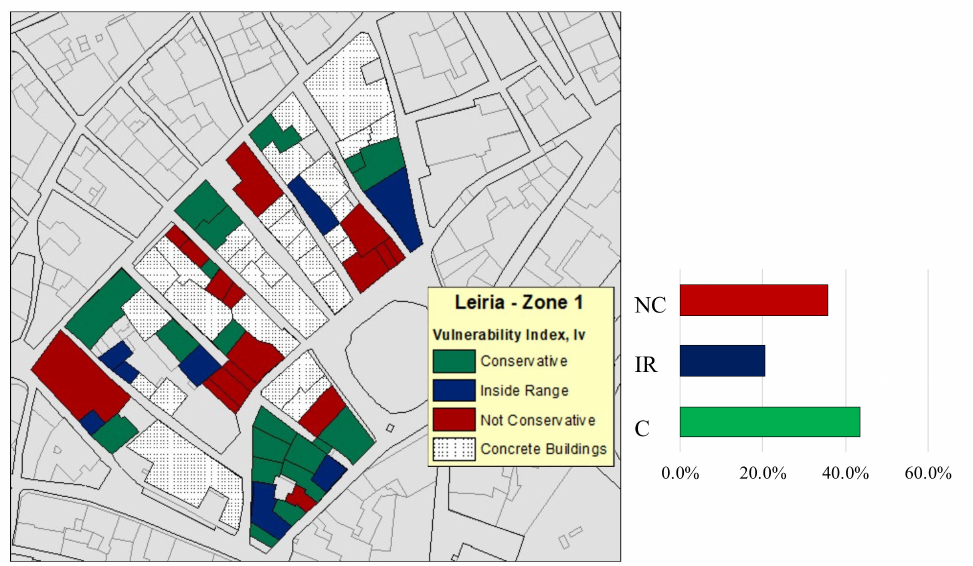
Figure 9. Comparison between the indexes calculated in this work and the field-campaign reference